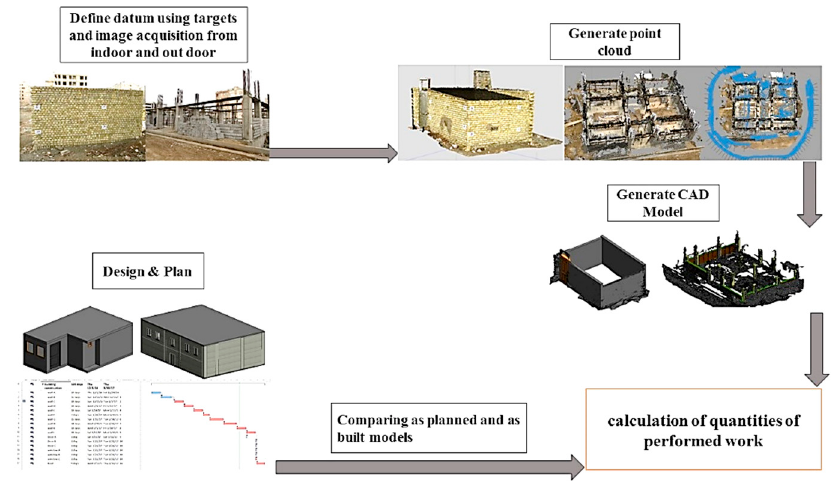
Figure 2. Schematic process for automated progress calculation that implemented on two case study, buildings orientations were 15°W–20°E of north.